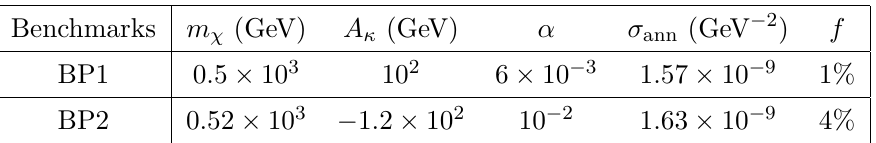
Table 1 . Benchmarks for realizing correct relic density without any constraints. We set r inf = 1 for simplicity. The f is fraction of BSF cross-section over total cross-section